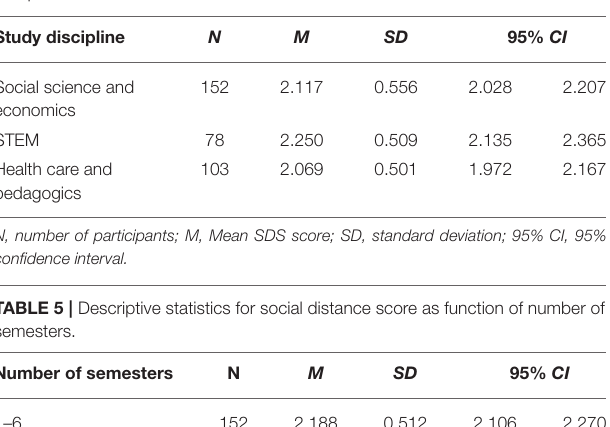
TABLE 4 | Descriptive statistics for social distance score as function of study discipline.